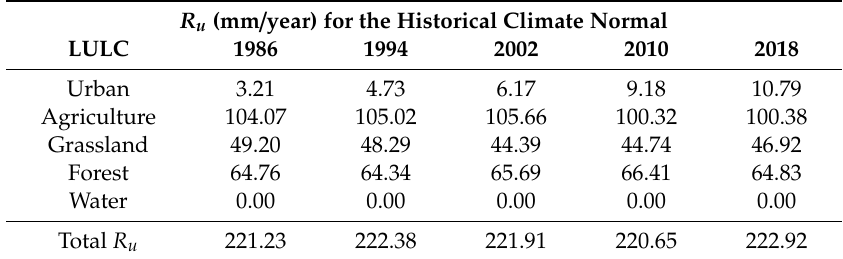
Table 8. R u values for the historical climate normal and for the five LULC categories.